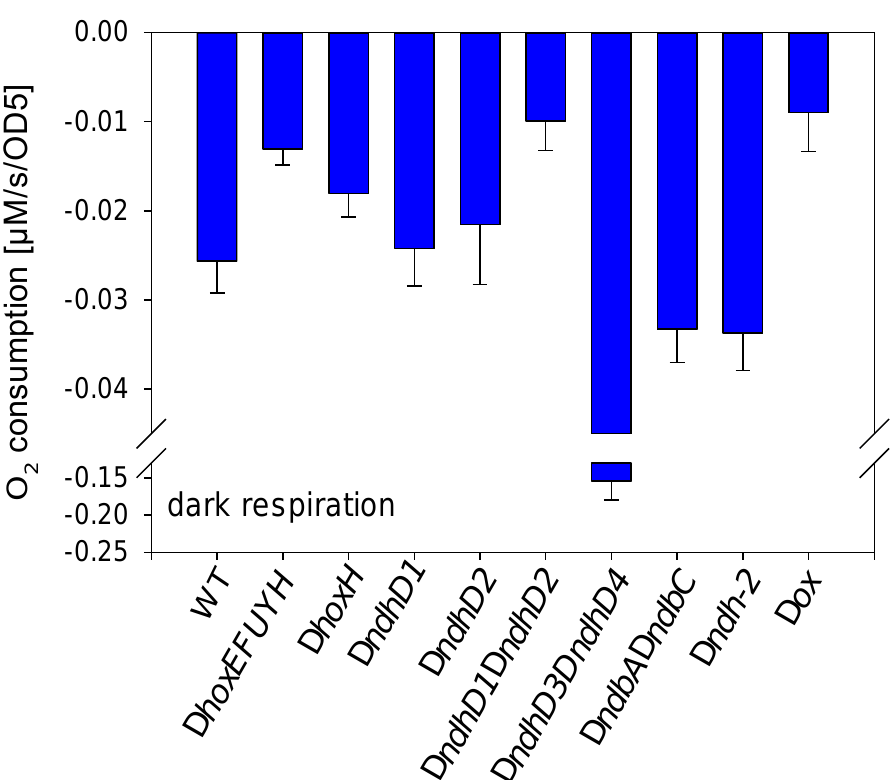
Figure 2. Dark respiration of different deletion strains of Synechocystis sp. PC 6803. Cell density was adjusted to the same OD 750 and oxygen uptake measured for 5 min in the dark. The rate of oxygen uptake was taken from at least three different cultures of the same strain of the last 3 min. Error bars represent standard deviation.